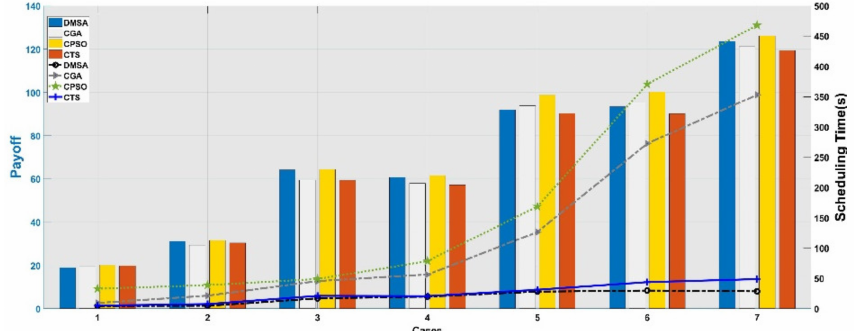
Figure 6. Payoff and scheduling time. Histogram shows the payoff of different algorithms’ optimiza- tion results, while the curve shows the scheduling